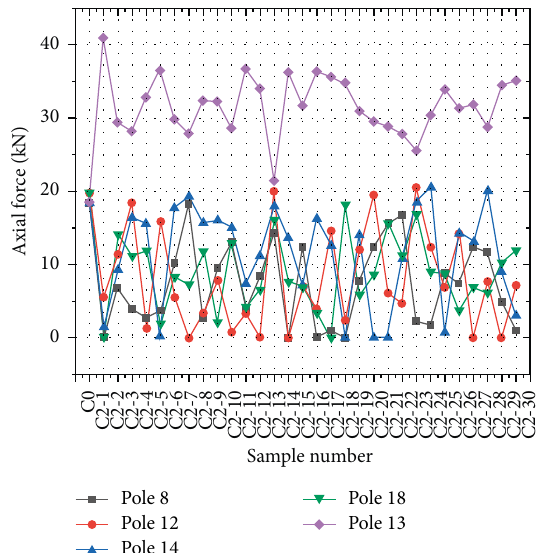
Figure 11: Axial force value of the vertical poles in the gap interval